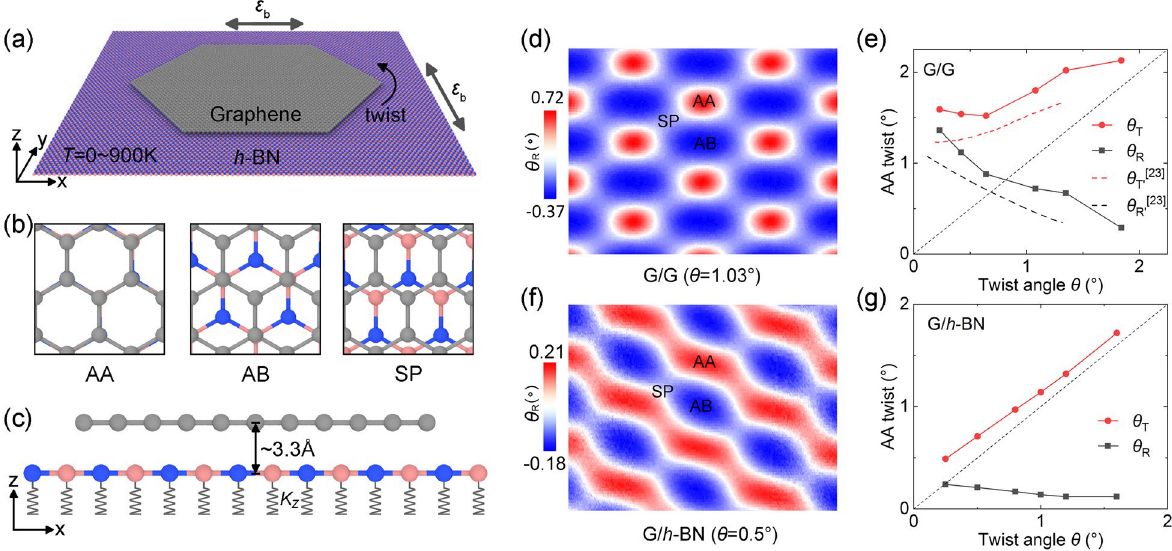
Figure 1. Schematic of the G/ h -BN bilayer model and its verification. ( a ) A hexagonal graphene flake with width of 13.7 nm is placed on an infinite h -BN monolayer under heterostrain ε b (0–10%) and temperature T (100–900 K). ( b ) Atomic configuration of three initial stacking modes, AA, AB, and SP. ( c ) The lower h -BN layer is supported by independent linear springs with stiffness k z = 2.7 nN/nm. ( d – g ) Validation of the bilayer models. ( d ) The distribution of local twist angles θ R is consistent with the previous experiments 23 . ( e ) The local AA twist with the applied twist angle agrees with the experiments 23 . ( f , g ) Results of G/ h -BN are analogous to those of